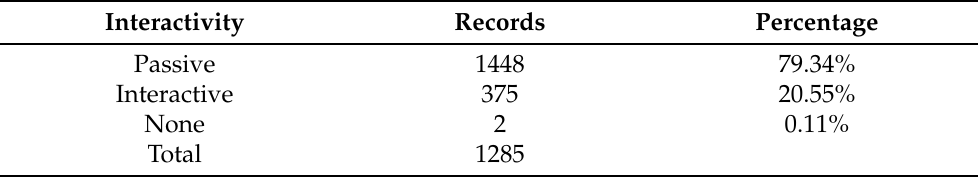
Table 4. Sensor network deployment distribution by interactivity of the goal